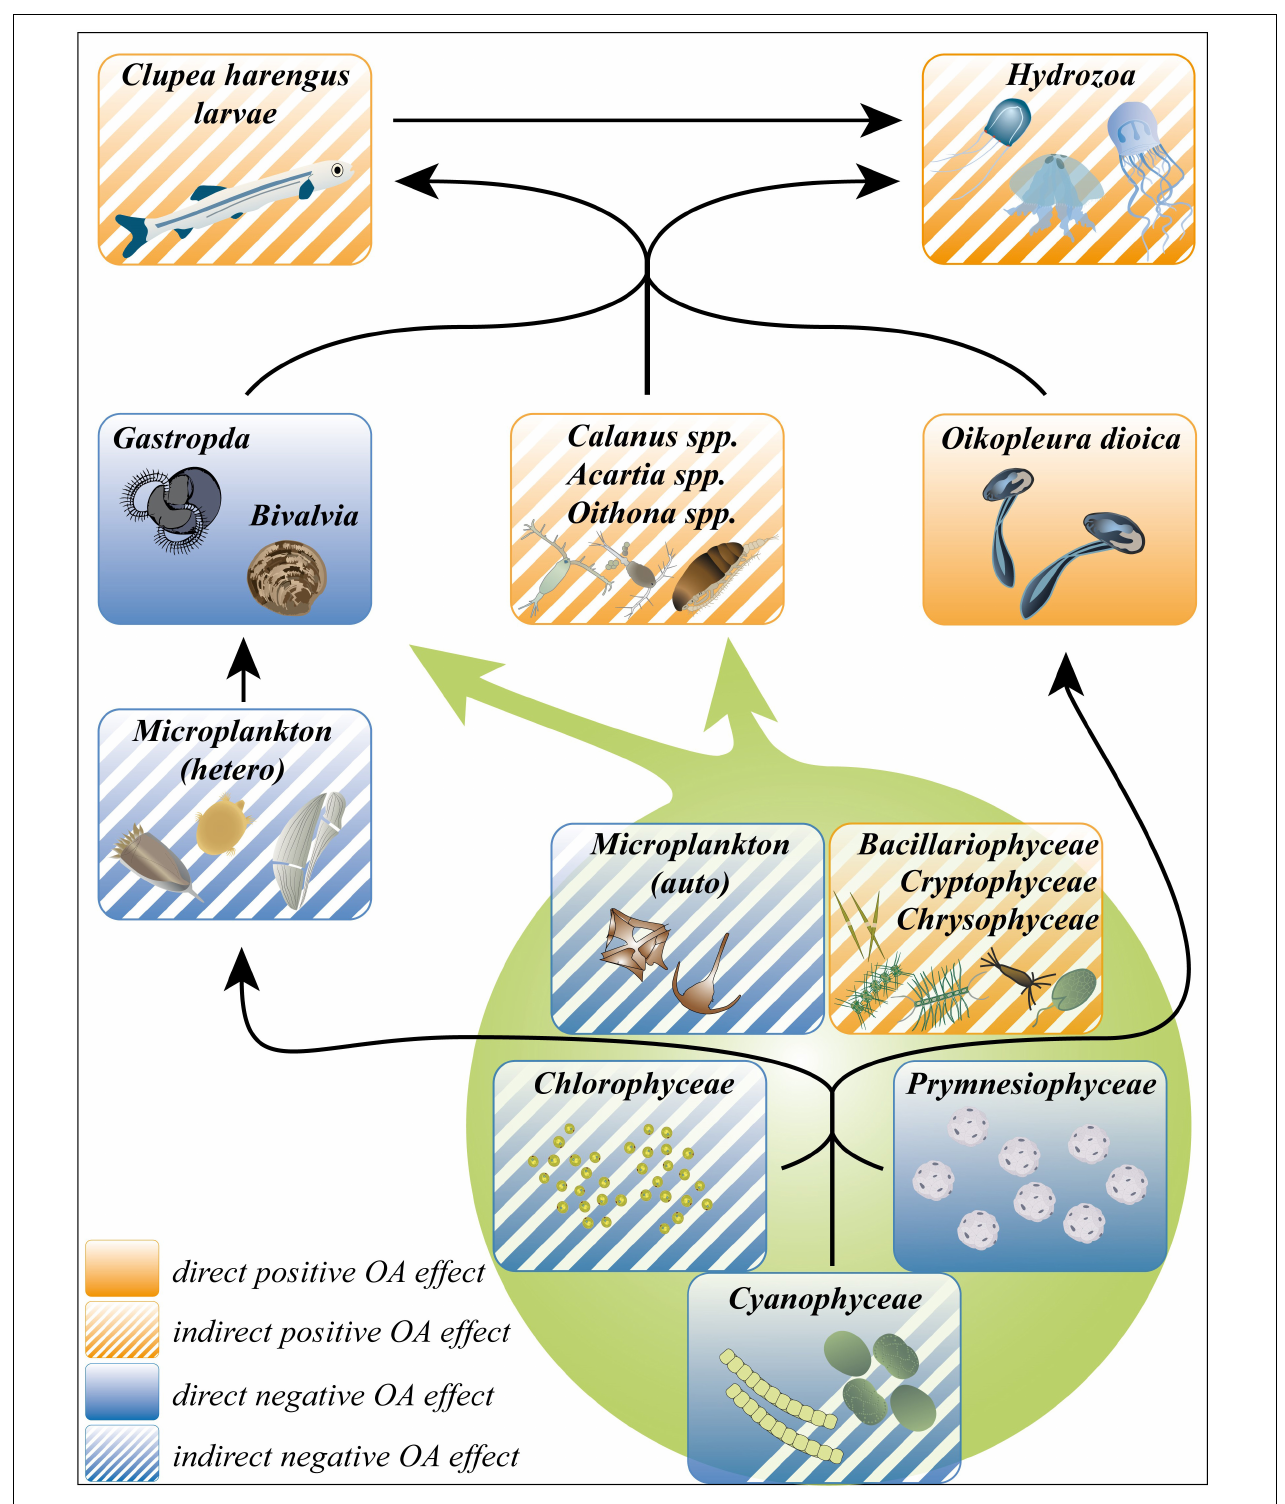
FIGURE 10 | Overview over the positive and negative, direct and indirect OA effects within a simplified food web of our high p CO 2 treatment mesocosms. Squares containing a mixture of filled and hatched area indicate both direct and indirect OA effects on the contained taxa. Black arrows indicate the direction of biomass transfer due to the predator-prey relationships between the single taxa. Green circle summarizes all affected phytoplankton taxa. Symbols taken from “Courtesy of the Integration and Application Network, University of Maryland Center for Environmental Science (ian.umces.edu/symbols/)”, accessed 25.08.2020; Figure design Susanne Schorr, assembled and designed with Adobe Illustrator CS4 (Adobe-Inc, 2008).